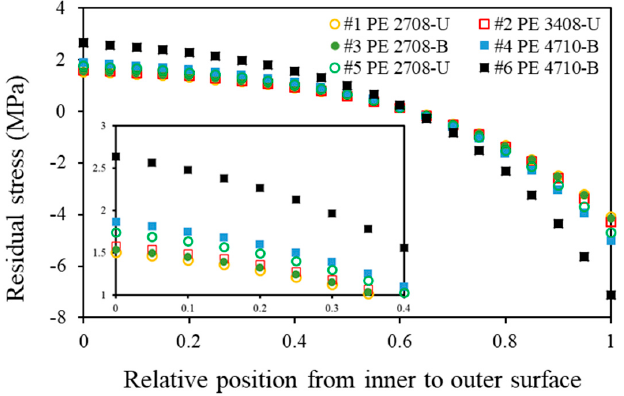
Figure 8. Residual stress distribution along the wall thickness for the six PE pipes.